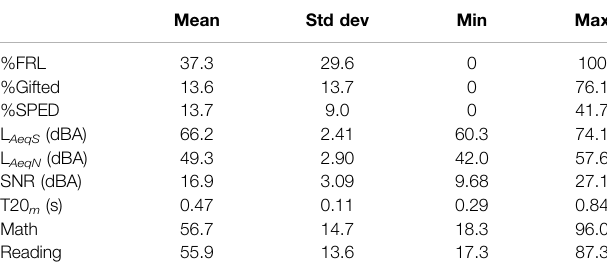
TABLE 2| Descriptive statistics ofthevariables inthis investigation. These include classroom demographics: the percent of students receiving free or reduced- pricelunch(%FRL), thepercentofgiftedstudents(%Gifted),thepercentofspecial education students (%SPED); acoustic metrics: the A-weighted equivalent levels of the speech (L AeqS ) and non-speech clusters (L AeqN ), the SNR taken as their daily difference, and the mid-frequency averaged reverberation time (T20 m ); and the test score outcomes in math and reading, given in terms of percentile